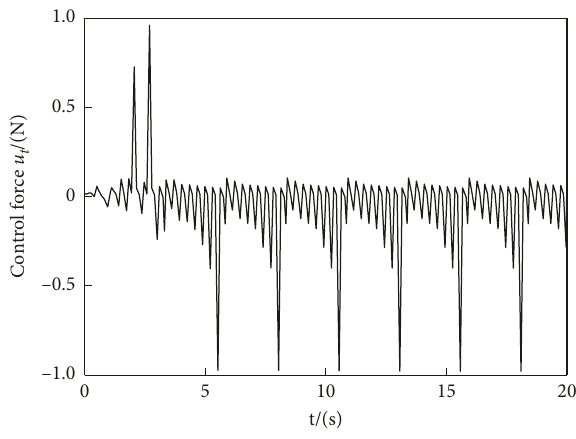
Figure 6: Control force using mode control